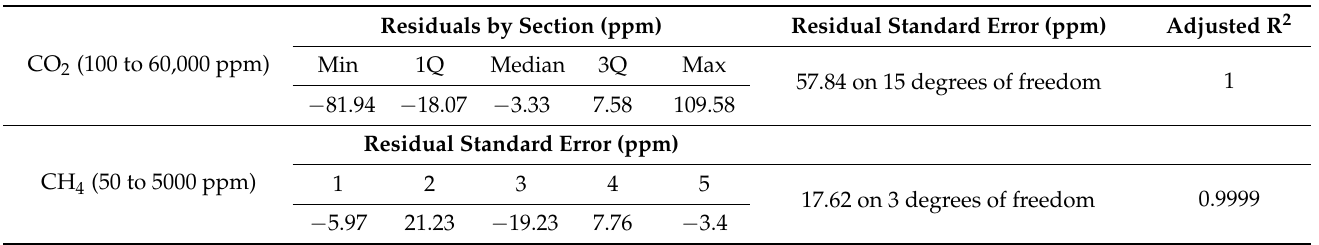
Table 1. The residual error and the adjusted R 2 of the two polynomial model fitting of CO 2 and CH 4 (Resolution: 1 cm − 1 ).